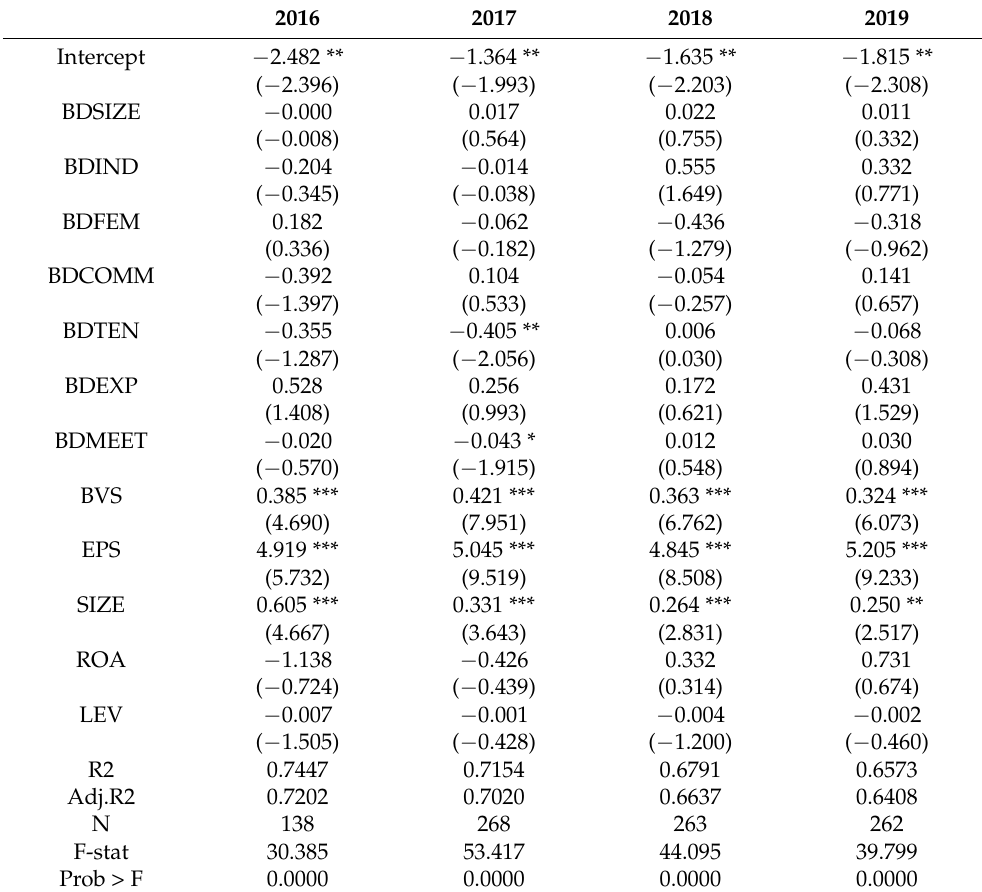
Table 8. Results of yearly regression of board attributes on PRICE